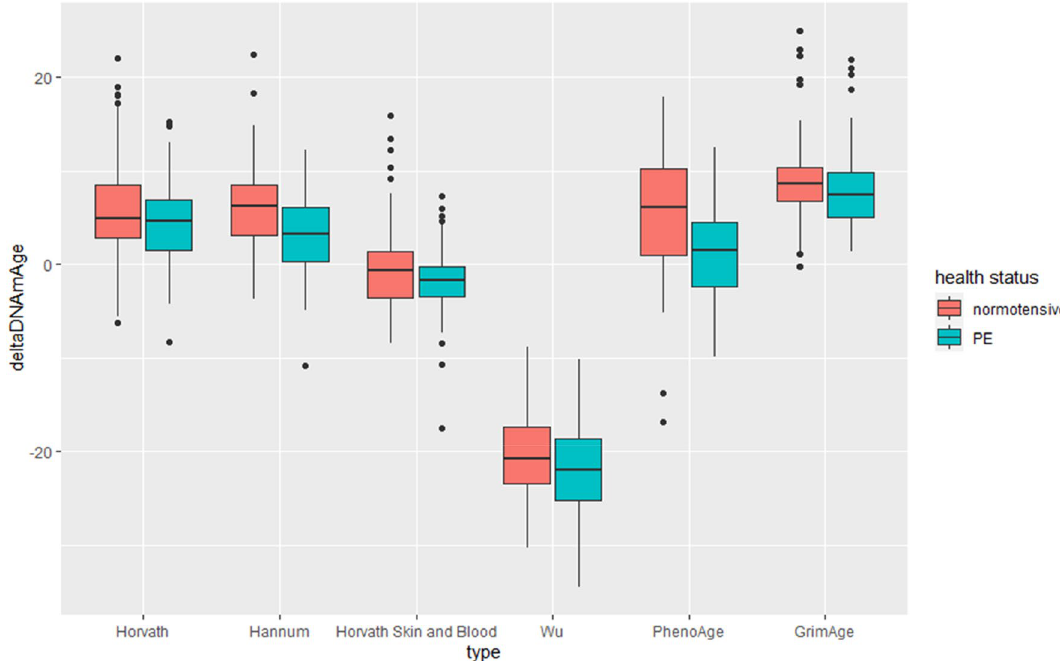
Figure 3. Six different Δ DNAm Age which represents the absolute difference between DNAm Age and chronological age in women with normotensive and preeclamptic (PE) pregnancies.